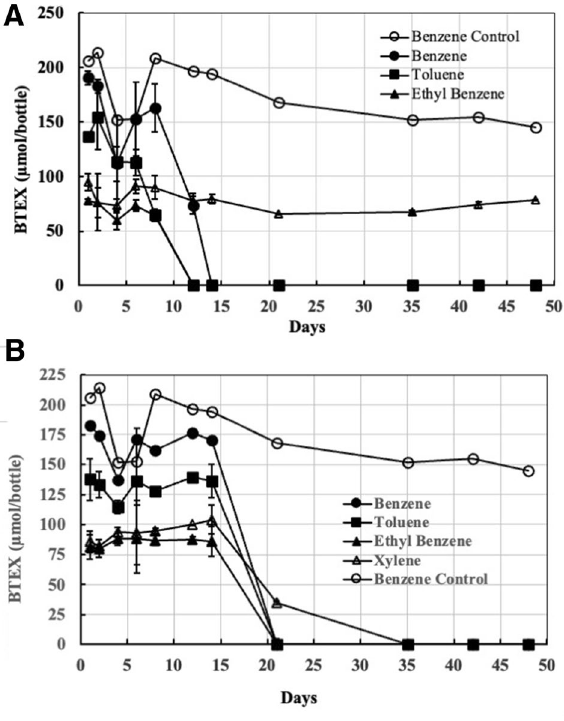
Figure 5. Degradation of BTEX in PW (no nutrients except the added hydrocarbons) as the sole source (s) of carbon amended individually ( A ) and together ( B ). Microcosms containing 48 ml of formation PW were inoculated with 2 ml (roughly 1.2 × 10 6 CFU) of strain Wilcox and closed with Teflon-coated septa and aluminum crimps. Autoclaved control microcosms amended with benzene, toluene, ethylbenzene and/or xylenes were prepared similarly (only benzene data is shown). Degradation of BTEX was monitored at time points by injecting 100 µL headspace samples into onto a GC. Error bars indicate ± 1 standard deviation of triplicate bottles (n =